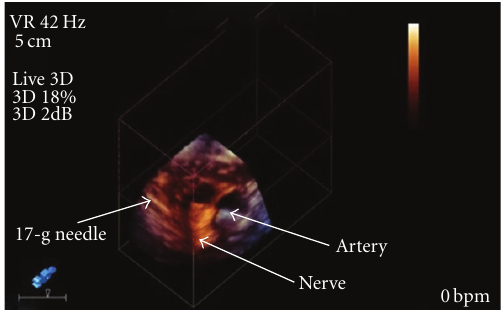
Figure 1: Oblique view of the needle at the posterior cord.